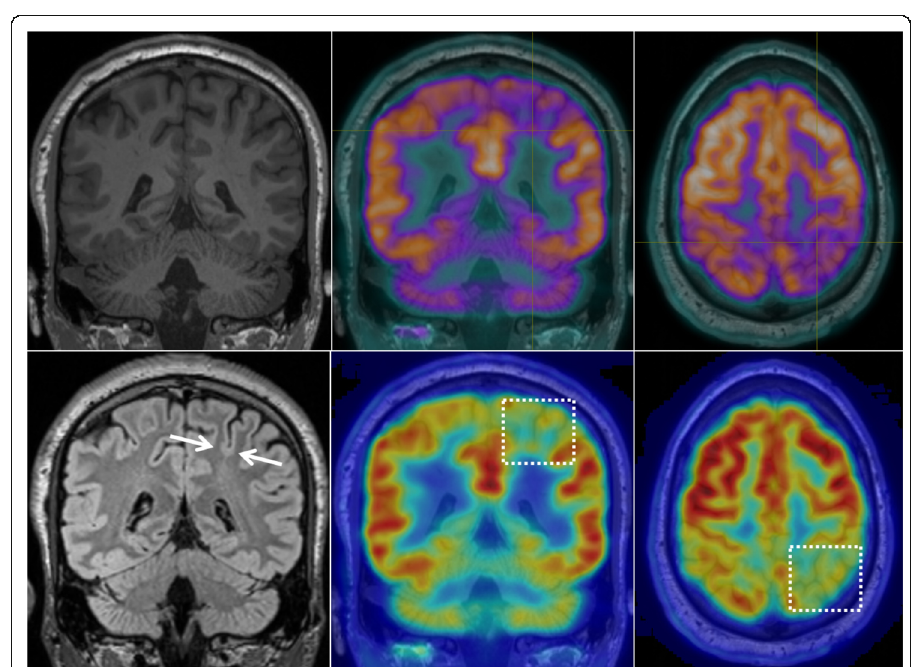
Fig. 4 MRI and PET images for an individual with regional PET hypometabolism. Regional hypometabolism was evident in this patient, with gradual decline in activity evident within the boxed area when compared to adjacent cortex. MRI was initially negative, and a subtle BOSD was detected only upon the second review of MRI with co-registered PET in this patient (arrows shown on FLAIR in bottom left image). This patient was seizure free following focal resection of the BOSD